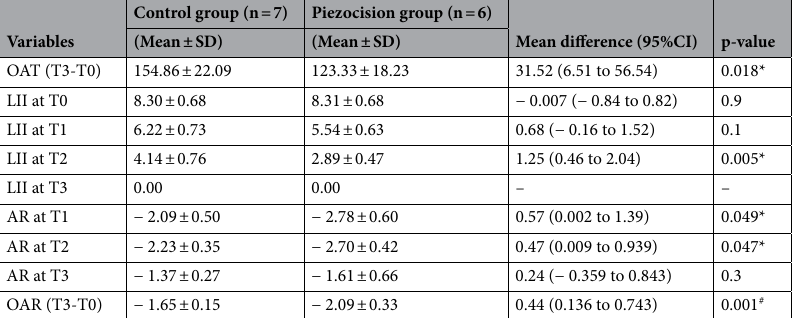
Table 2. Overall alignment time (in days), changes in Little’s Irregularity Index (LII) (mm), and changes in alignment rate (mm/month) between control and piezocision group. OAT: Overall alignment time, LII: Little ˈ s irregularity index, AR: Alignment rate, OAR: Overall alignment rate, *Alignment rate, # repeated measure ANOVA comparing the